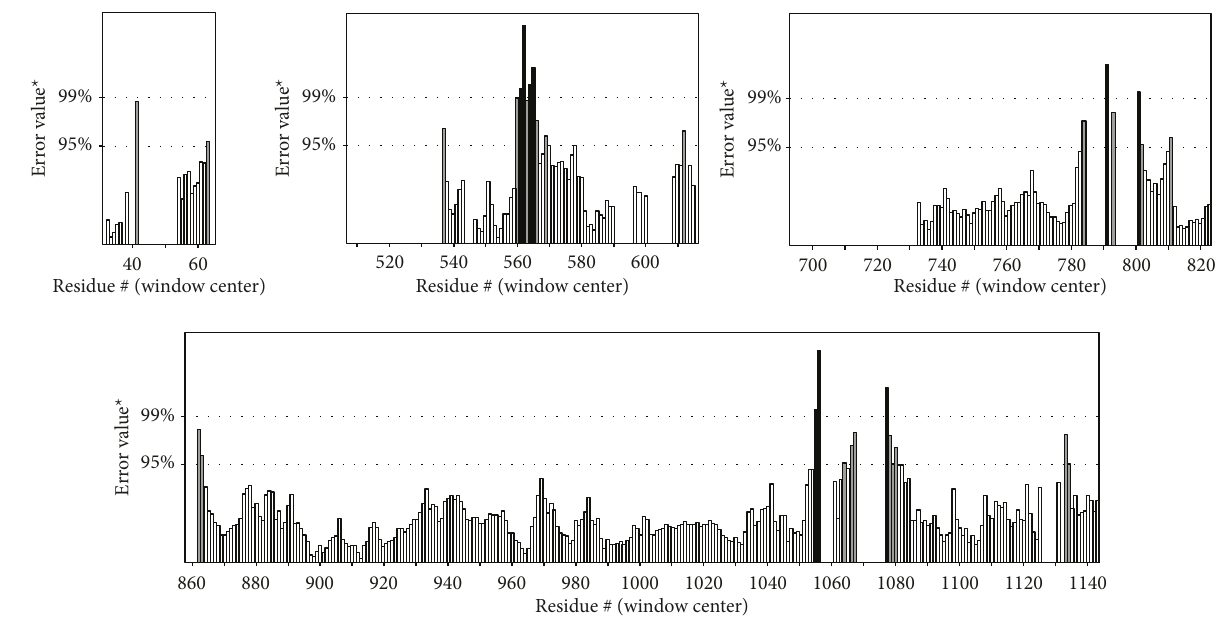
Figure 5: Evaluation of protein model of SARS-CoV-2-SG by SAVES.